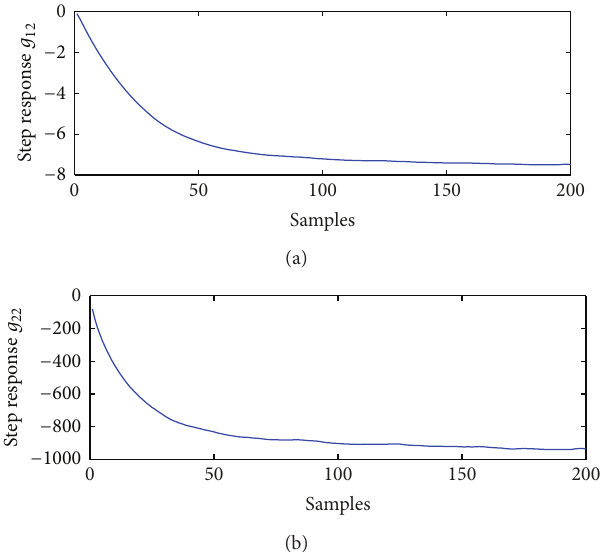
Figure9:Stepresponsecurveofbiodieselconcentrationandreactor temperature, respectively, under 𝐹 𝑐 action.